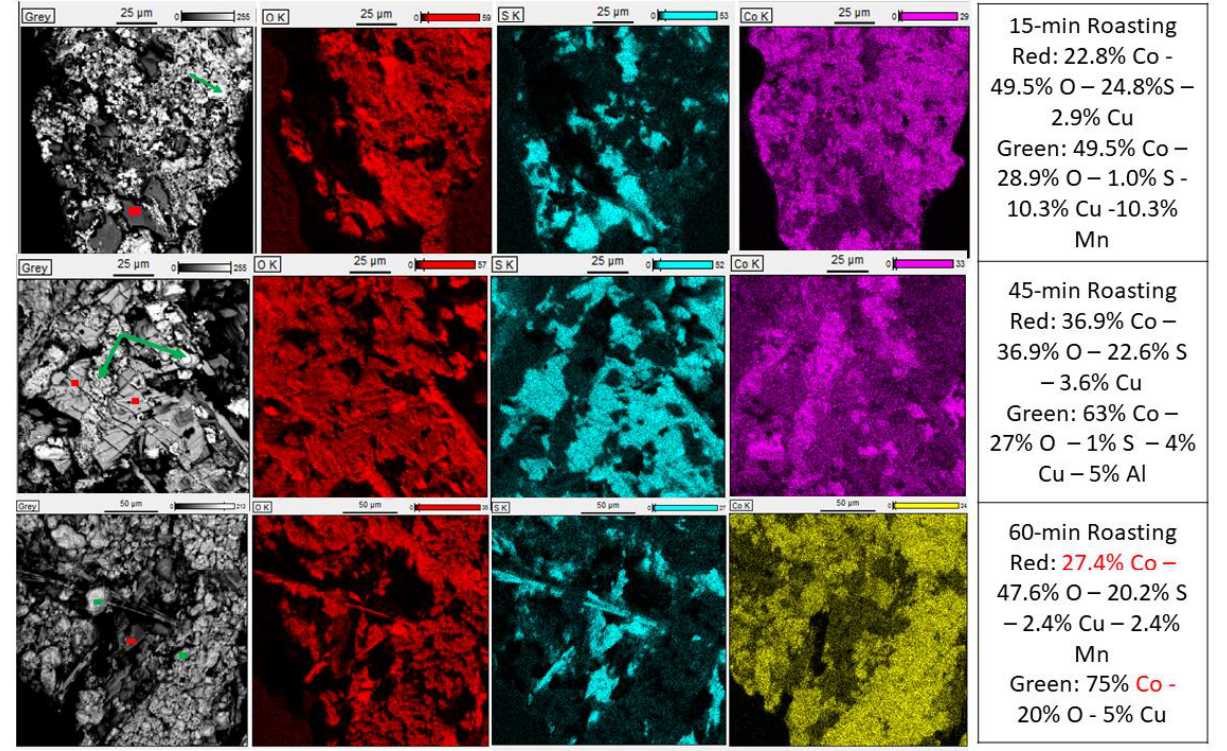
Figure 11. Composition mapping from SEM – EDS for 15-min, 45-min, and 60 min sulfation roasted samples with additional pre-roasting along with composition of the ‘ red ’ and ‘ green ’ marked regions.